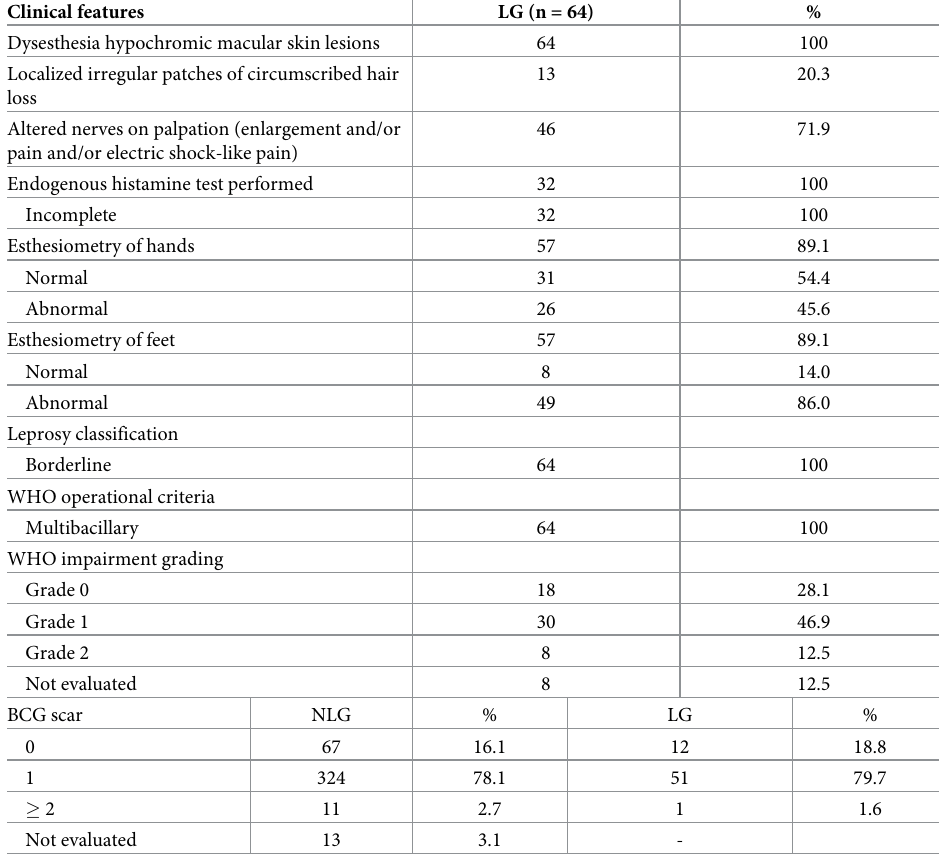
Table 4. Clinical characterization of Jardino´polis patients regarding the percentage of positivity to the clinical cri- teria used for the diagnosis of leprosy (n = 64). Clinical features